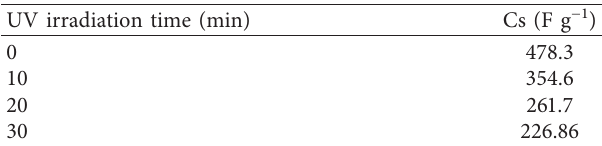
Table 2: The calculation results of Cs values of PANI/GO/Azo at different UV irradiation